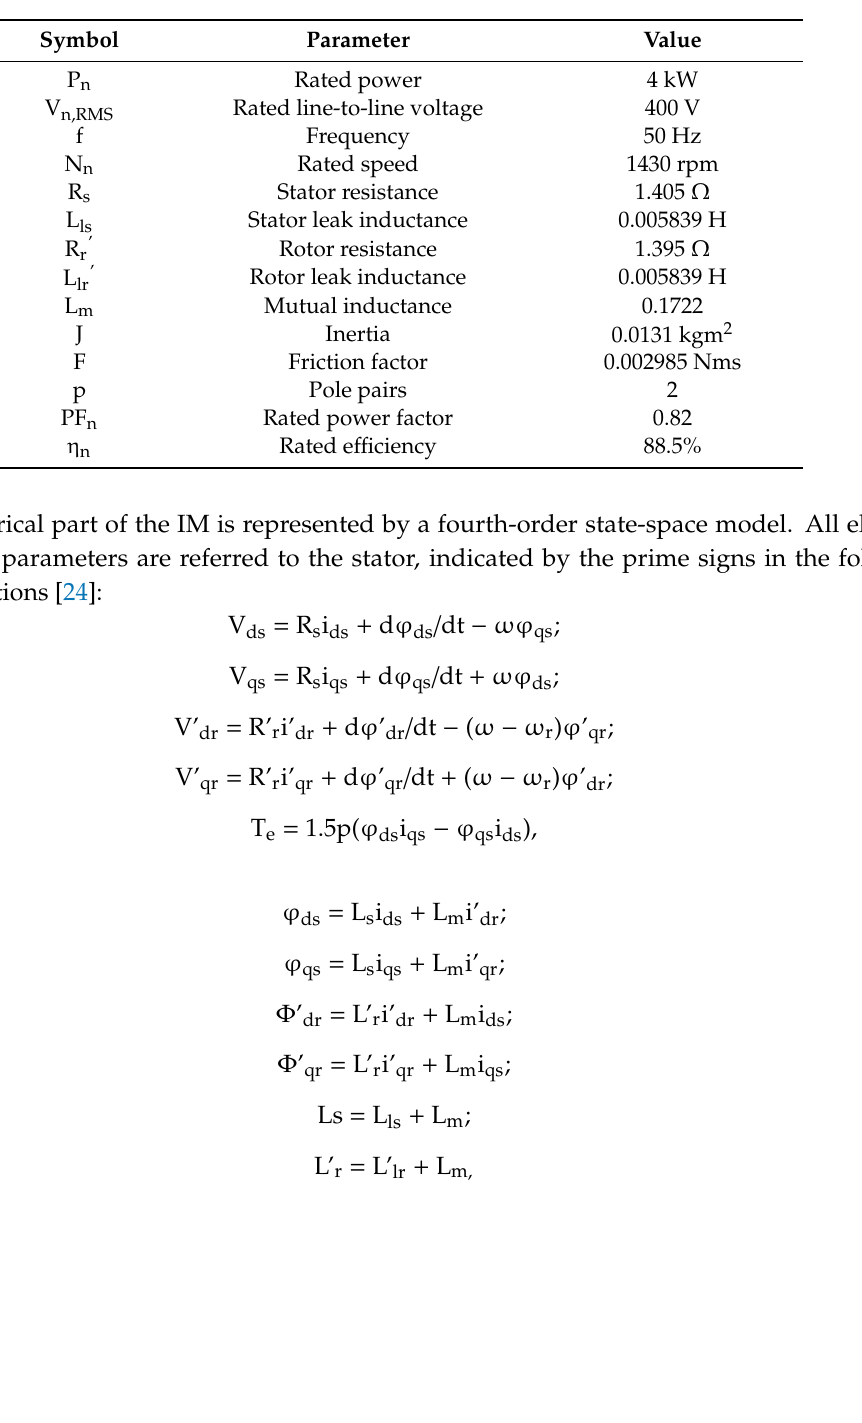
Table 1. Parameters of the induction motor